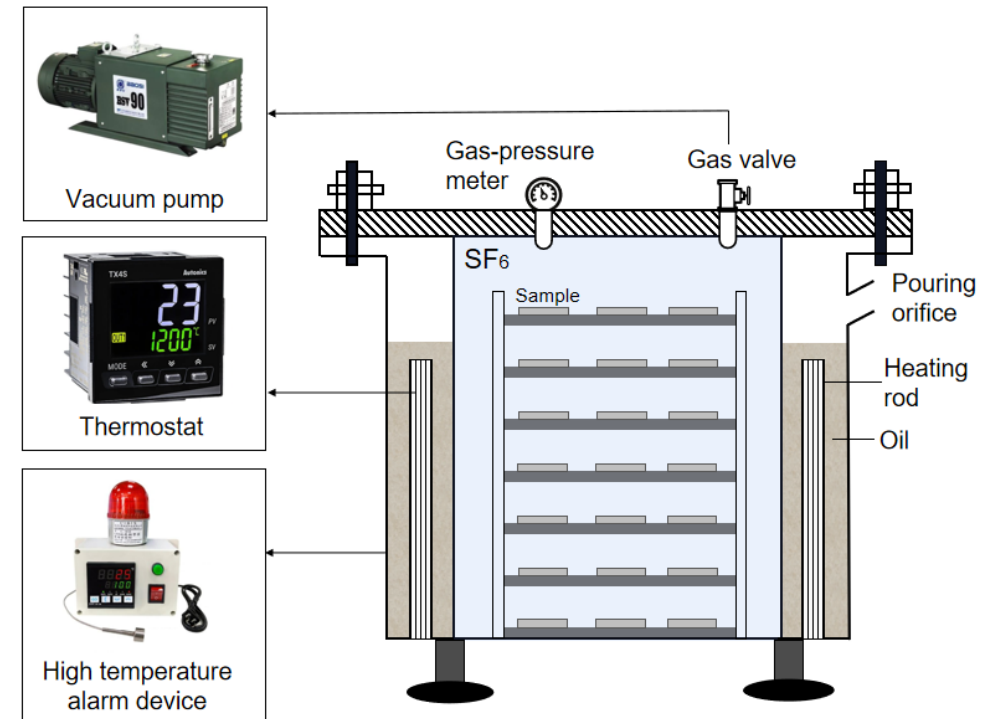
Figure 1. Closed constant temperature heating platform in SF 6 .